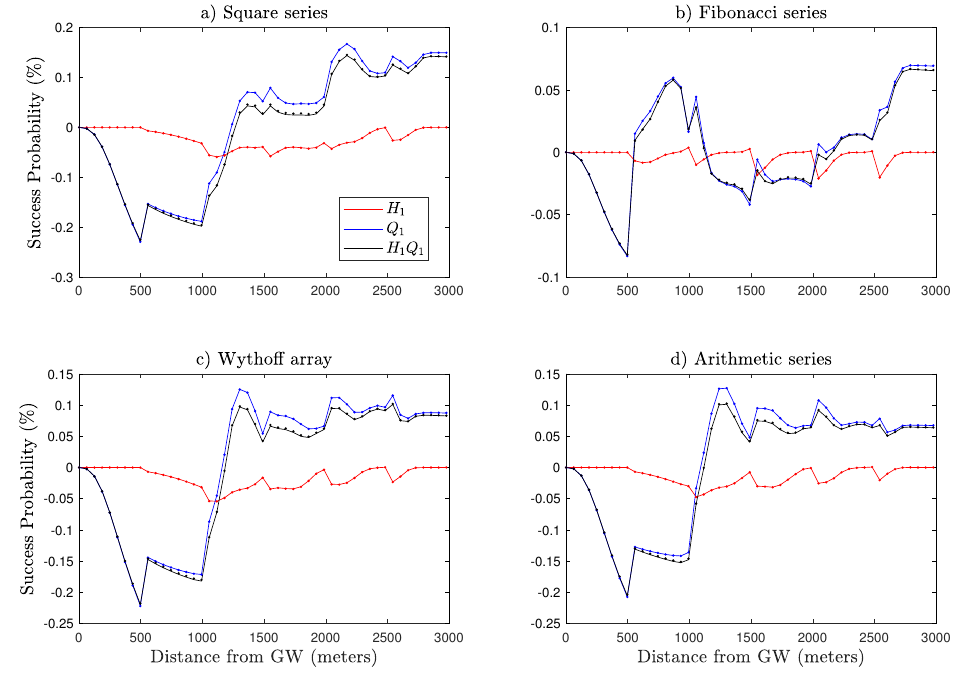
Figure 7. Comparison of performance gain of different series with respect to the baseline model for ¯ N = 500, network size of R = 3 km with p 0 = 1%, and path loss exponent η =